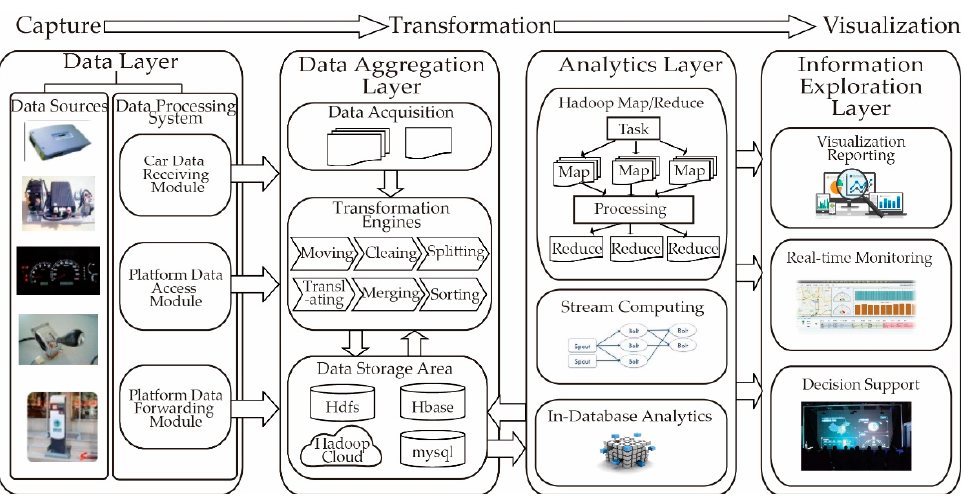
Figure 4. Big data analytics architecture of the Service and Management Center for EVs (SMC-EV) in Beijing.